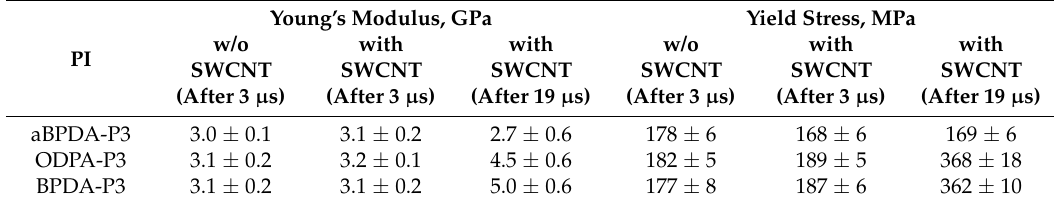
Table 1. The Young’s moduli and yield stress values for the simulated PIs aBPDA-P3, ODPA-P3, and BPDA-P3 after 3 and 19 µ s of simulations (before and after the structural transition to the unfolded states). The results for the unfilled samples (without SWCNT) were calculated using the samples obtained in our previous study